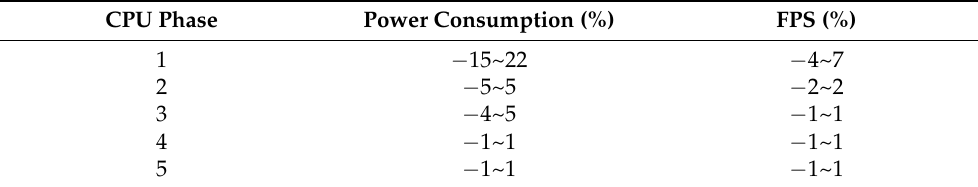
Table 1. Change rate of power consumption and FPS according to CPU phase when the CPU frequency is changed.